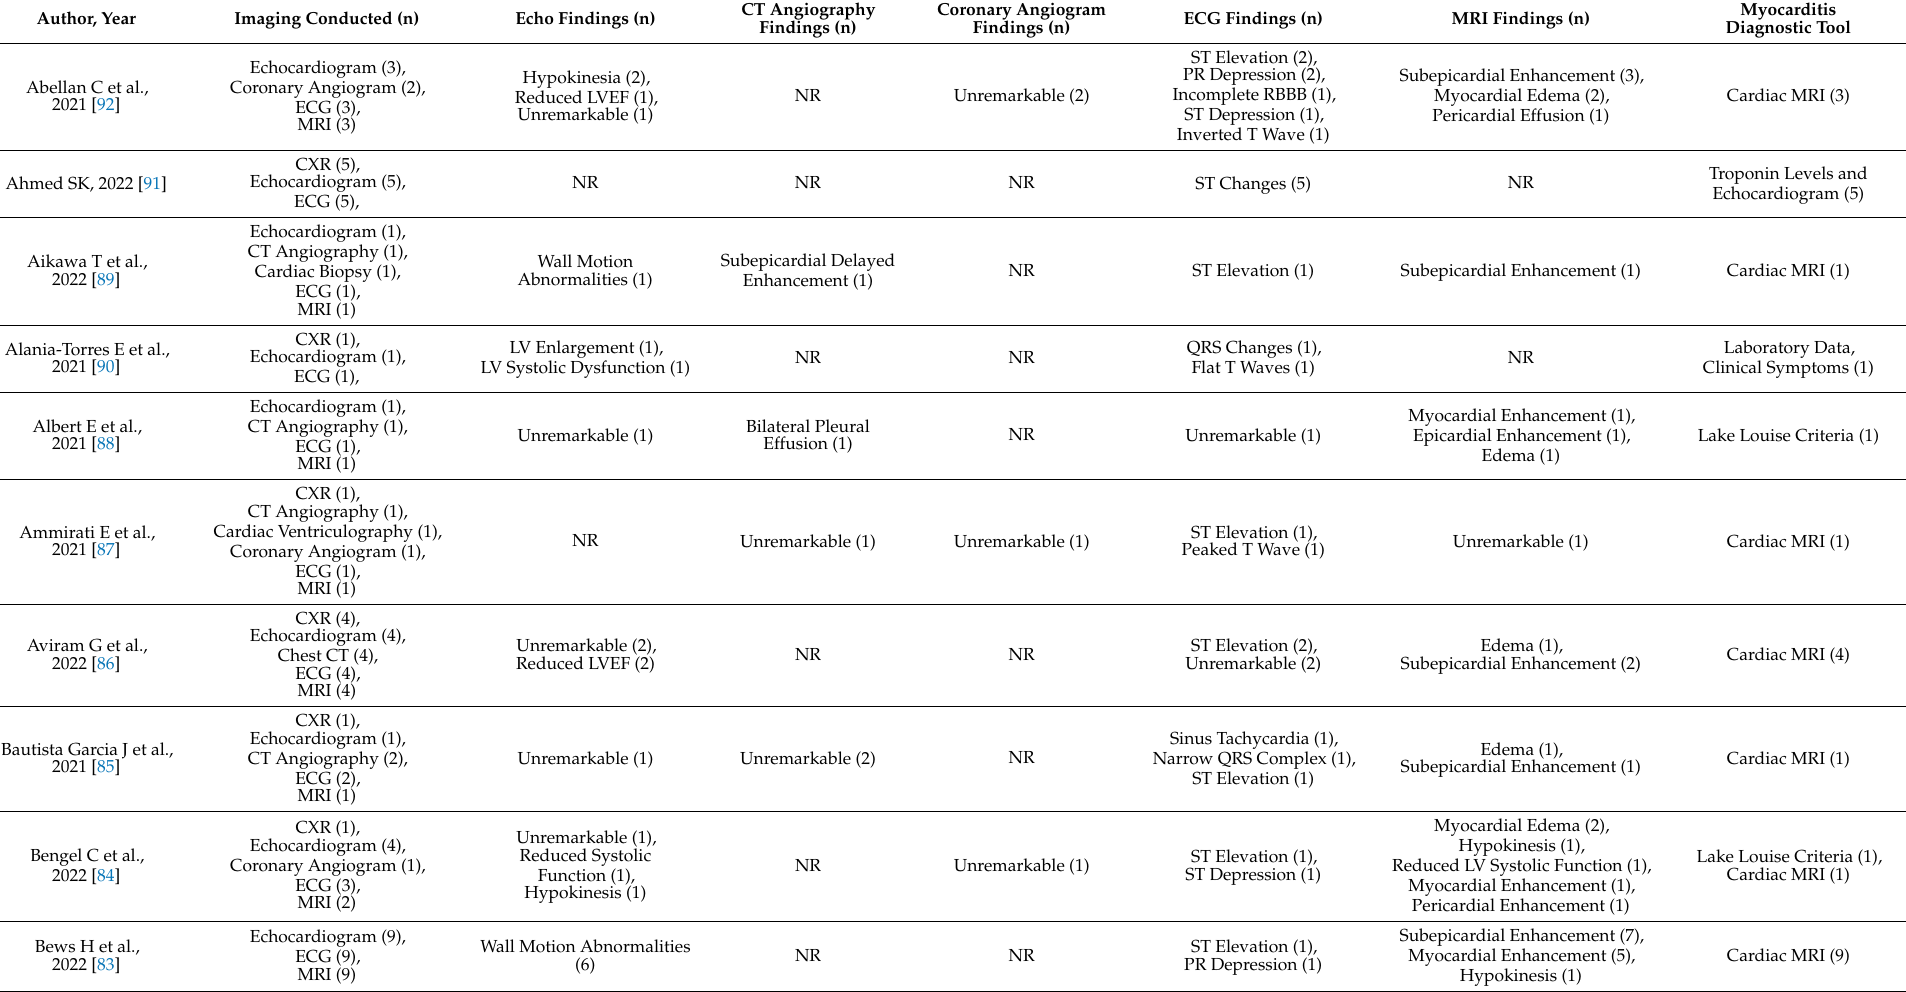
Table 3. Major Medical Imaging Findings on